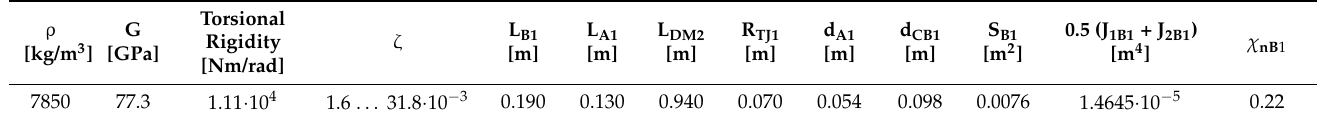
Table 2. Material and Geometry characteristics of DOE3 and TJ2.